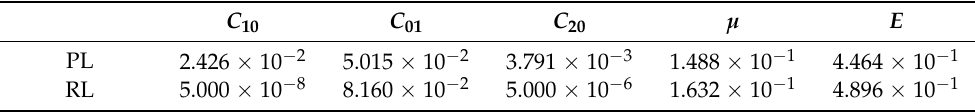
Table 1. Material parameters of the constitutive model (unit: